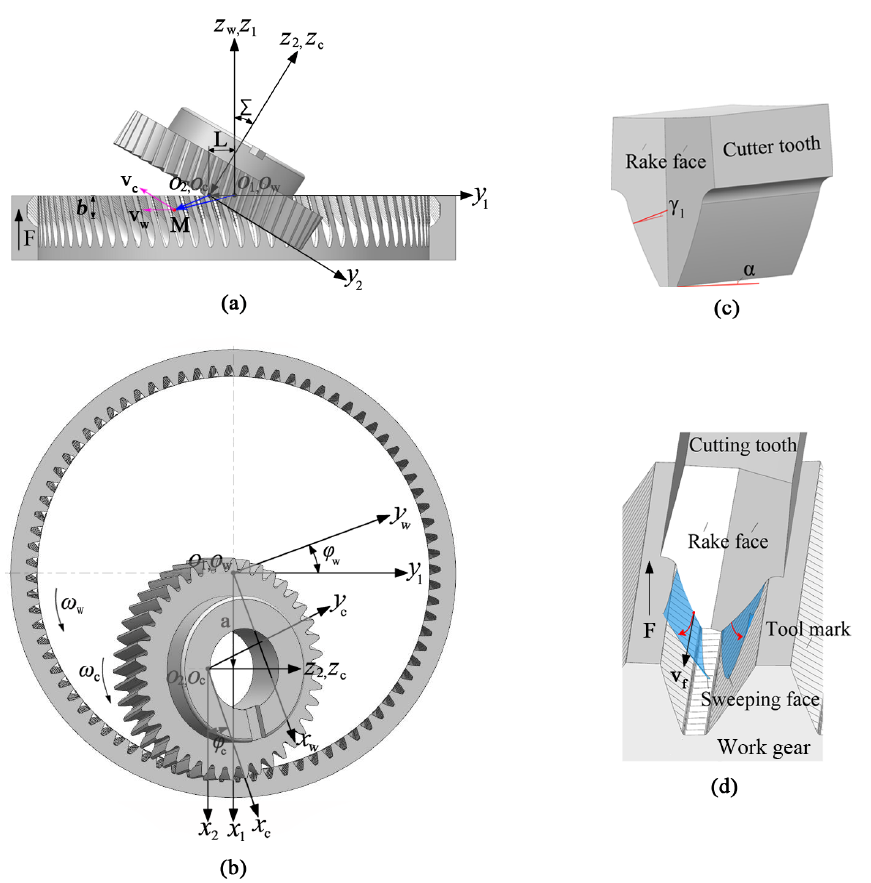
Figure 1. Skiving coordinate systems and double-rake-face skiving tool. ( a ) Front view, ( b ) Top view, ( c ) Tooth shape, ( d ) Tooth surface generation.